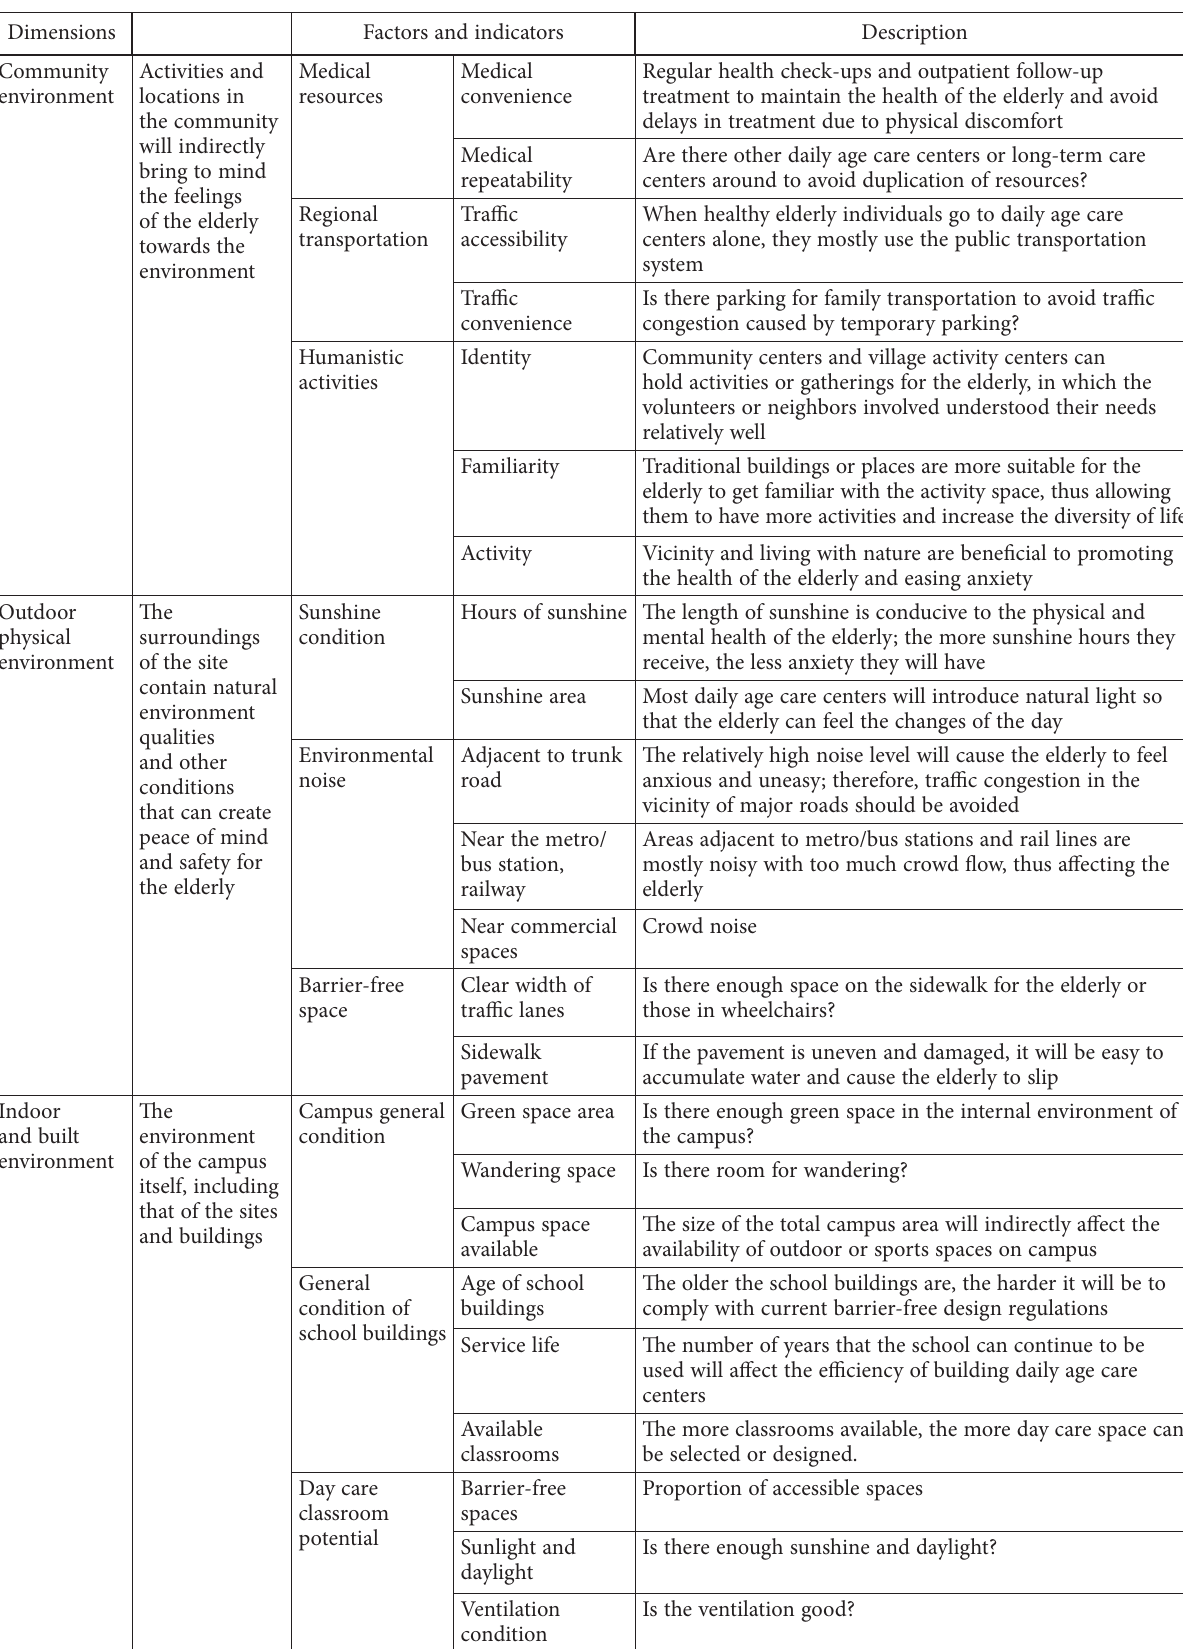
Table 2. Daily care center site selection factors and indicators for the aged Dimensions Factors and